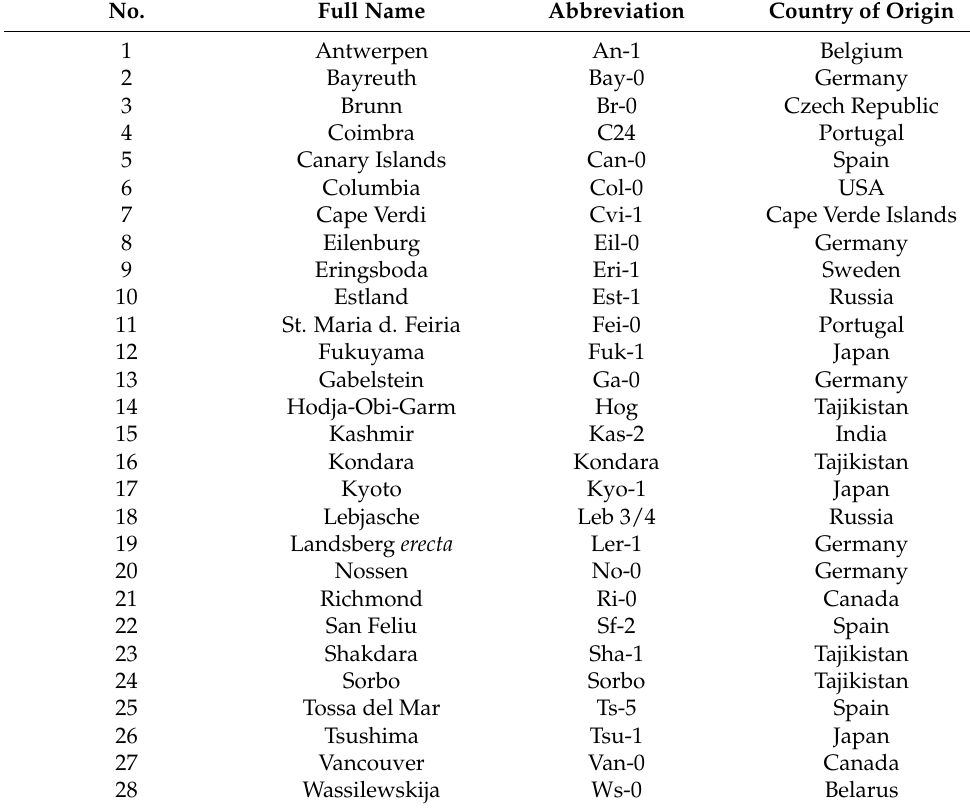
Table 2. Basic information on the Arabidopsis accessions used in this